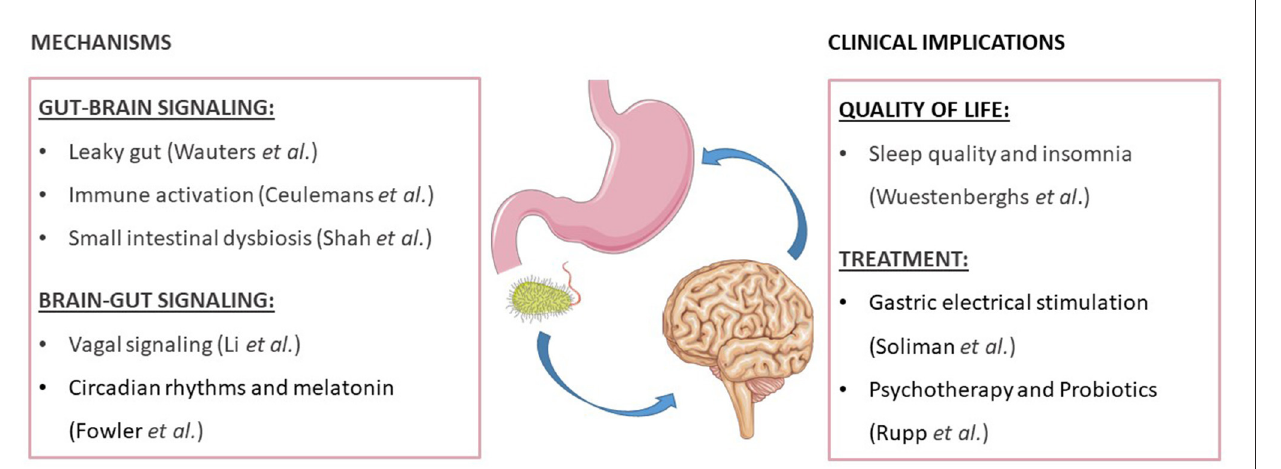
FIGURE 1 | Reviews and research focusing on the disruption of the microbiota-gut-brain axis in functional dyspepsia and gastroparesis. This figure was created with elements from